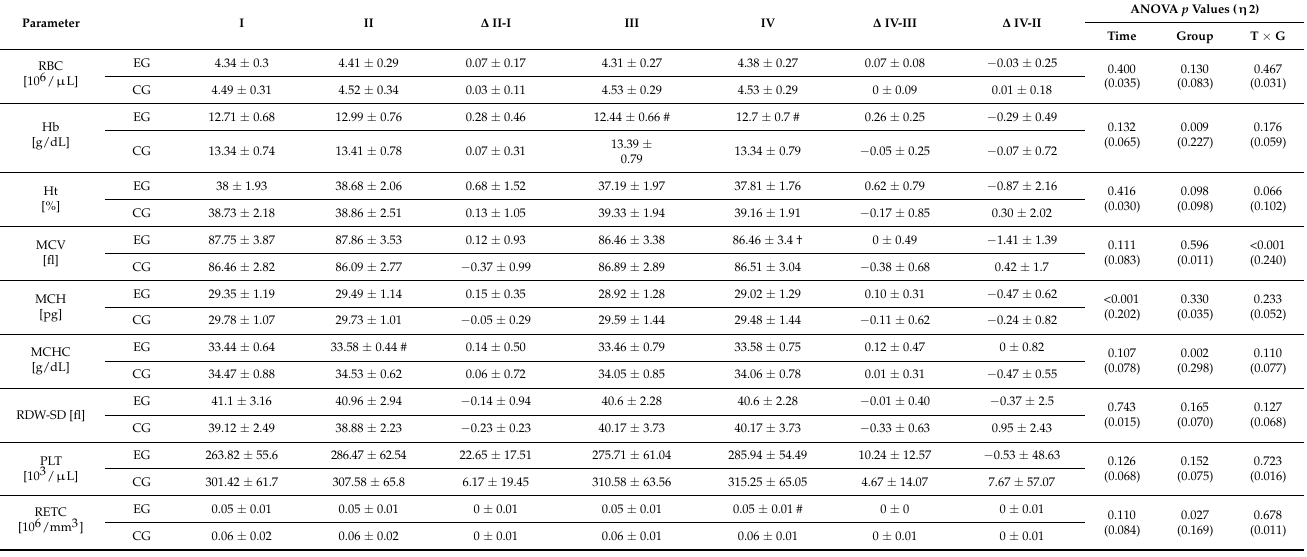
Table 3. Changes in hematological indicators after a single bout of exercise in experimental (EG) and comparison group (CG).